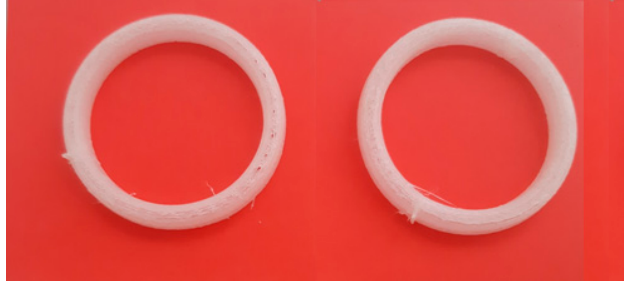
Figure 1. Image of the printed samples.